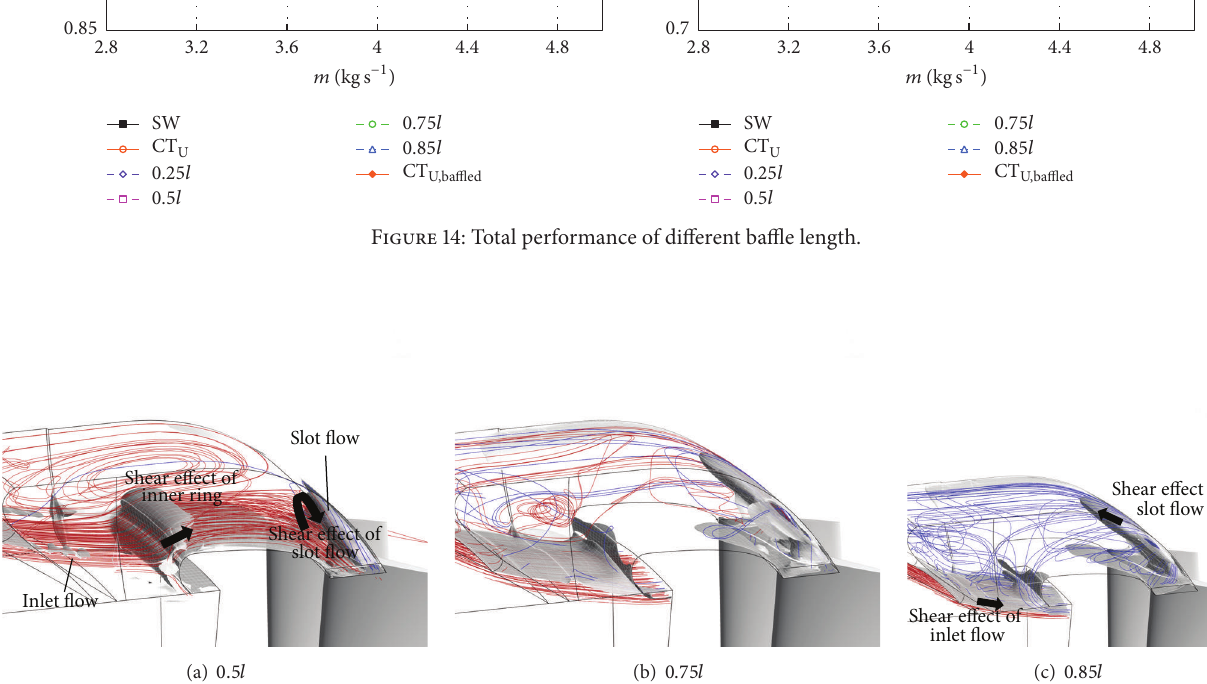
Figure 15: The dissipation in the recirculation